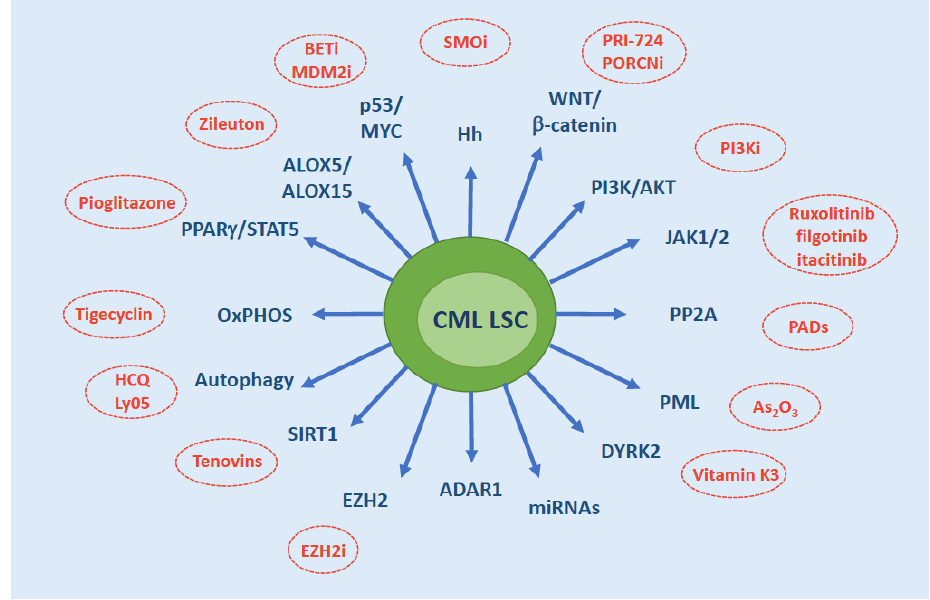
Figure 3. Overview of the molecules/pathways that have been implicated in CML LSC persistence. Therapeutic strategies that have demonstrated efficacy in vitro or in mouse models are indicated.